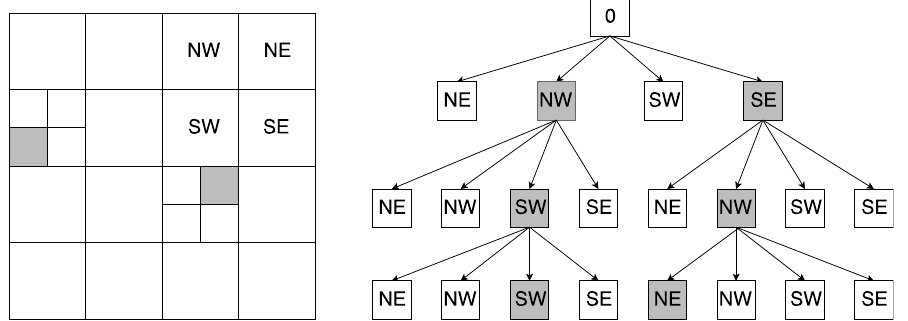
Figure 2. This figure illustrates a Quadtree hierarchical data structure where the gray cells indicate the route toward the two gray indicated occupied